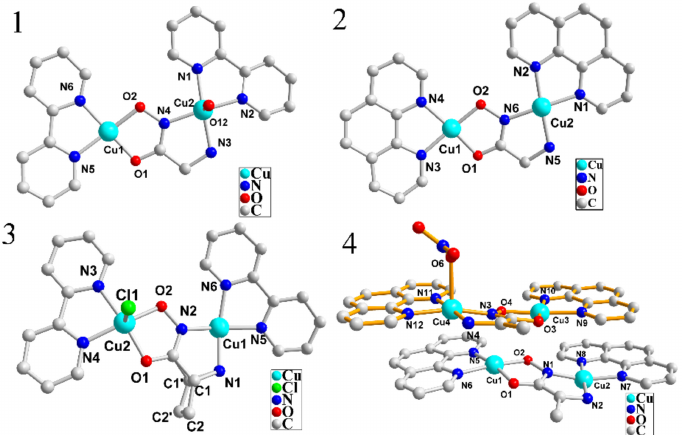
Figure 1. The molecular structure of complexes 1 – 4 (all hydrogen atoms and free anions are omitted for